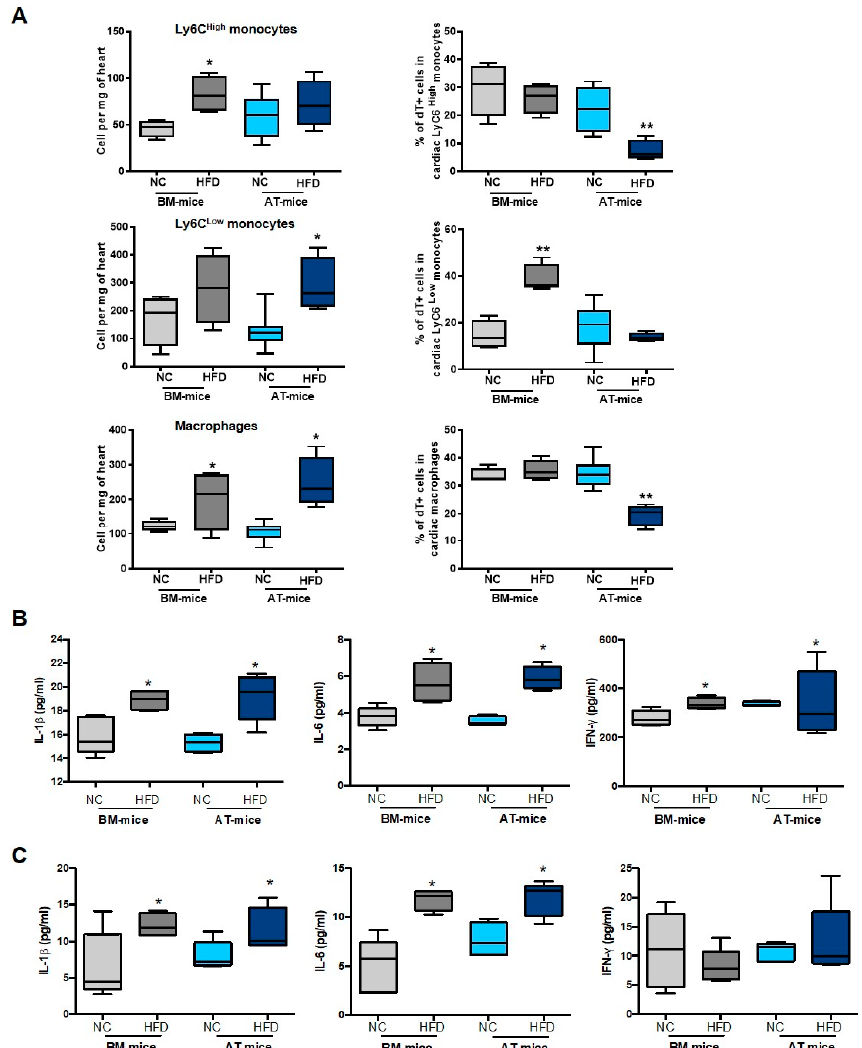
Figure 6 Diabetic chimeric mice exhibit higher cardiac inflammation. ( A ) Quantification of total and dT + Ly6C High and Ly6C Low monocytes, and macrophages in the heart of BM- and AT-mice fed a normal chow (NC) or a high fat diet (HFD) for 8 weeks (n = 4–8). ( B , C ) Cytokine levels in the heart ( B ) and the blood ( C ) of BM- and AT-mice fed a normal chow (NC) or a high fat diet (HFD) for 8 weeks (n = 4–5). Analyses have been performed 7 days after the onset of acute MI. Comparisons between groups were performed using Dunn’s multiple comparisons test.* p < 0.05 and ** p < 0.01 in HFD vs NC fed mice.